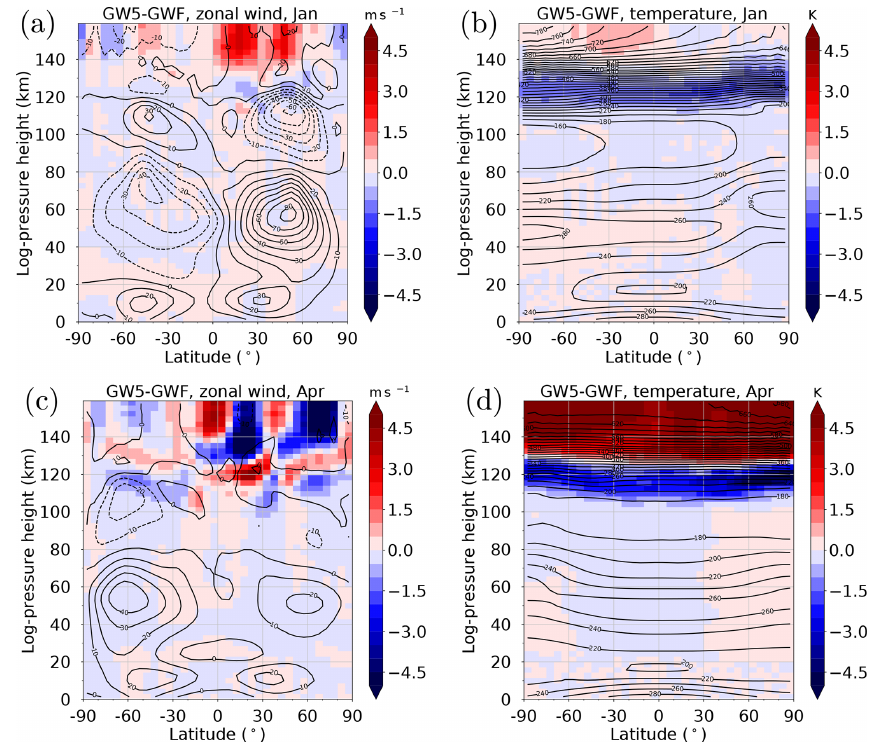
Figure 4. Contour lines: latitude–altitude distribution of zonal mean zonal wind (a, c) and zonal mean temperature (b, d) in the GW5 ensemble simulation for January (a, b) and April (c, d) . Color shading denotes differences compared with